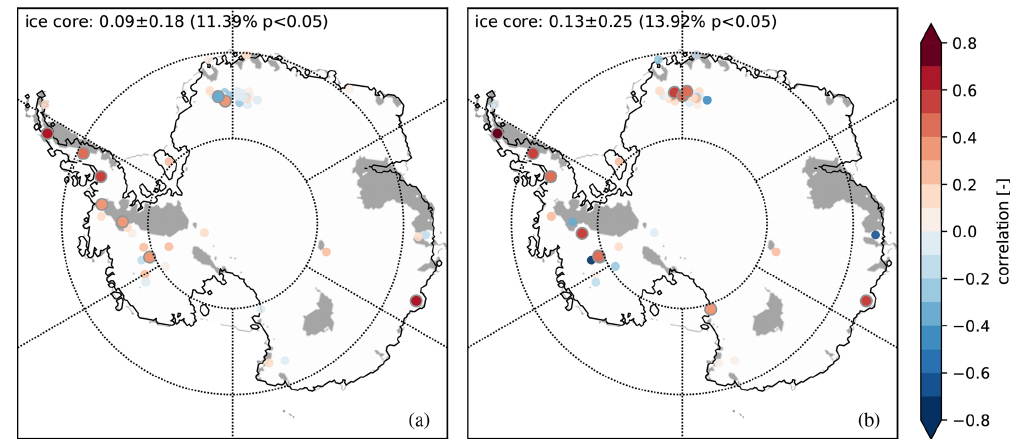
Figure 8. Ice core correlations (a) annually for SMB–SAT over 1958–2010 and (b) 5 yearly for SMB– δ 18 O over 1871–2010. Large grey encircled dots indicate that the correlation value is significant; smaller dots indicate a p value > 0.05. Statistically insignificant areas of the RACMO27 SMB–SAT annual correlation ( p > p FDR ) are hashed in grey for reference. The average annual correlation, standard deviation, and percentage of ice cores with p < 0 . 05 are provided in each